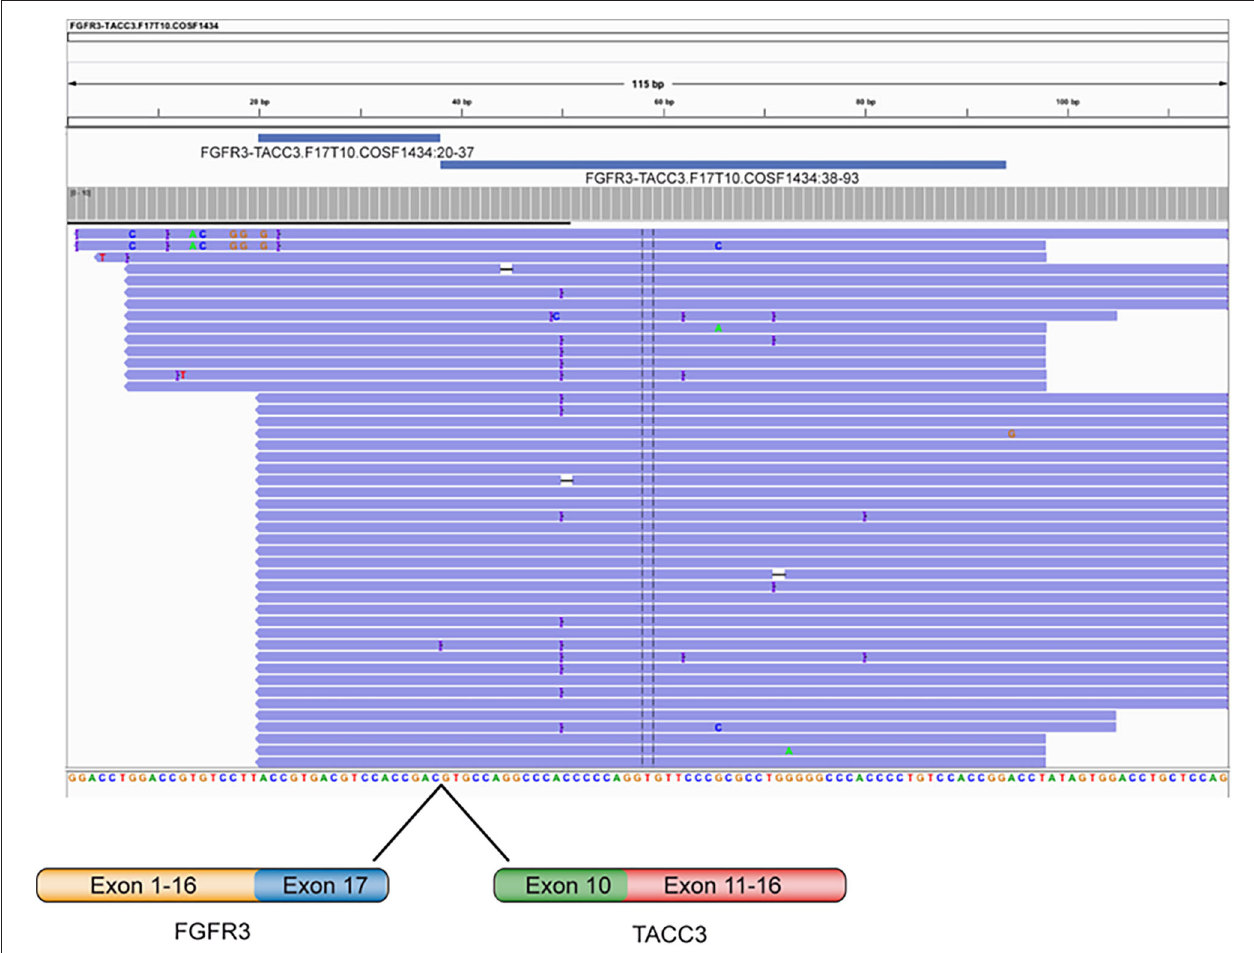
FIGURE 3 | Representation of the FGFR3-TACC3 fusion gene identified by Next Generation Sequencing in a GBM IDH wt patient. Visualization of RNA sequencing reads supports the fusion junction between FGFR3 exon 17 and TACC3 exon 10. 97 GBM cases, two of which harbored the FGFR3-TACC3